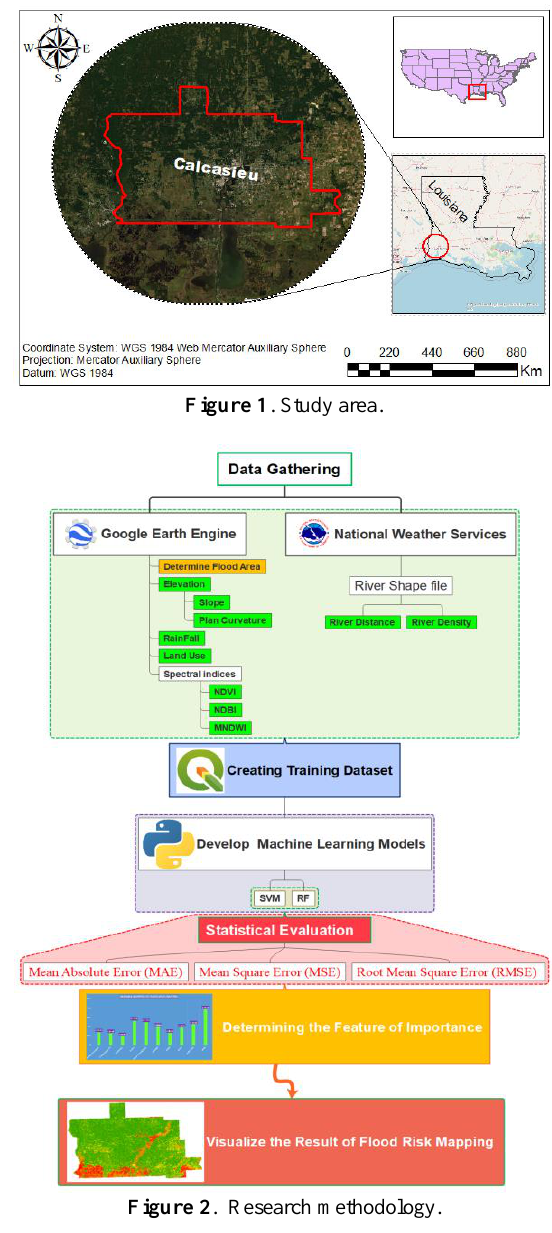
Figure 2 . Research